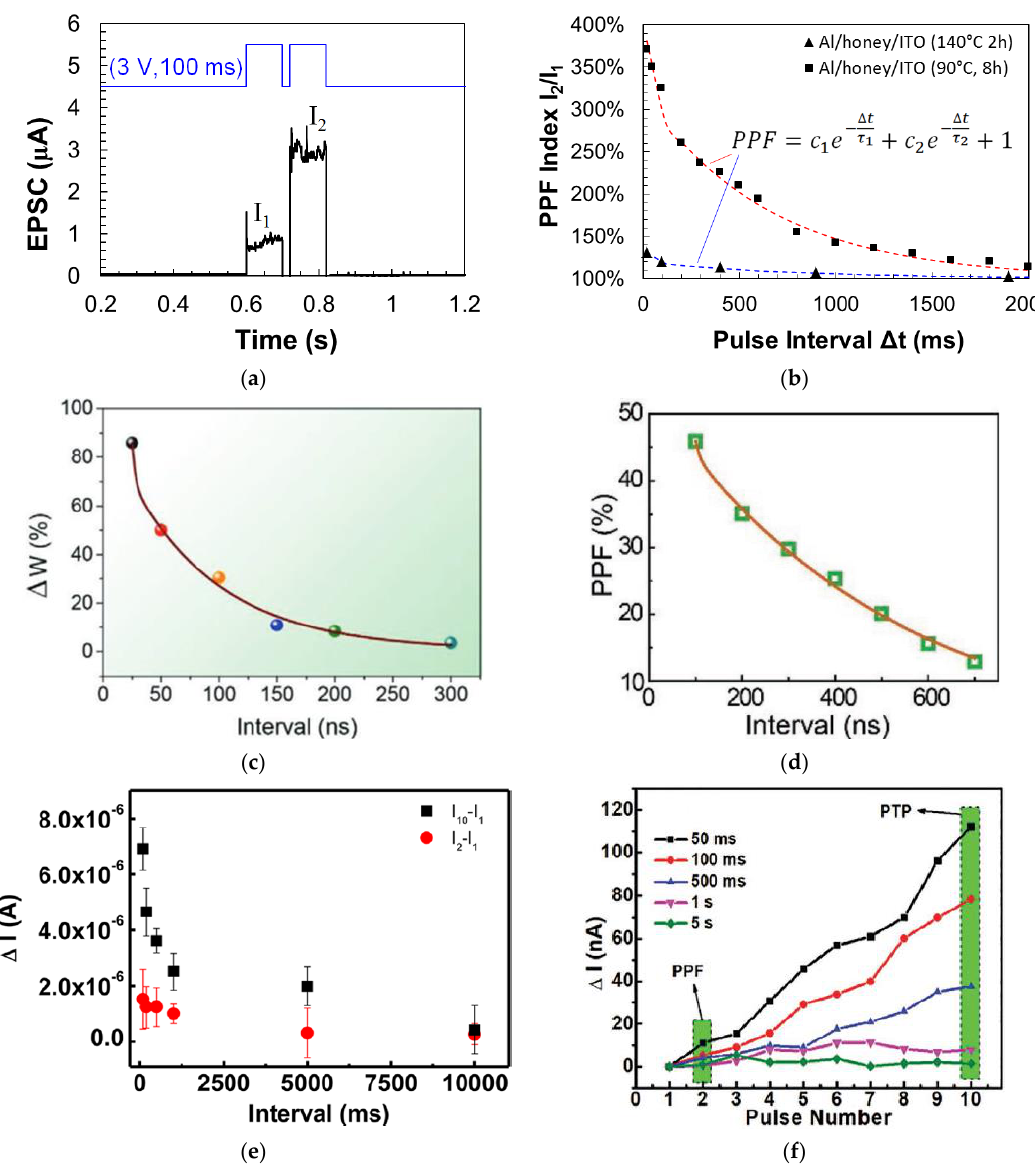
Figure 8. PPF characteristics and PPF index of synaptic memristors based on natural organic materials: ( a , b ) honey [20], ( c ) wool keratin [59], ( d ) silk [55], ( e ) lignin [24], and ( f ) cellulose [54]. In ( e , f ), PTP was also demonstrated.